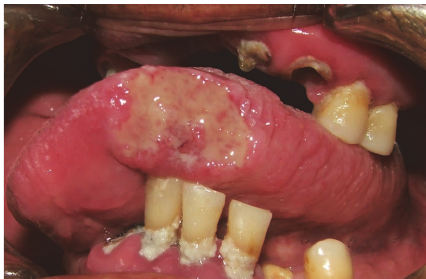
Figure 1: Lateral anterior border of the tongue showing a large ulcerated lesion with indurated borders.